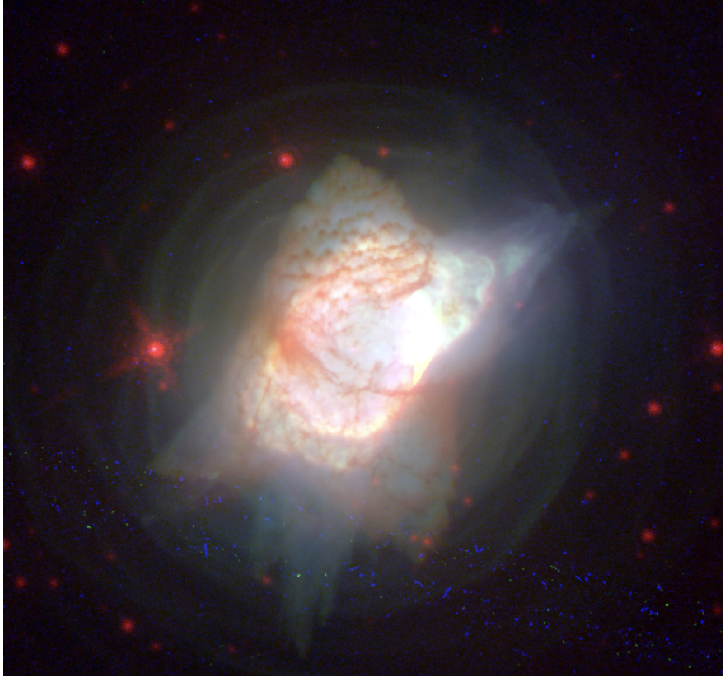
Figure 1. Color overlay of Cycle 27 HST/WFC3 narrow-band images of NGC 7027. Filter F343N ([Ne V ]) is blue, F502N ([O III ]) is green, and F164N ([Fe II ]) is red. The field of view is ∼ 38 (cid:48)(cid:48) × 38 (cid:48)(cid:48) ; north is up and east is to the